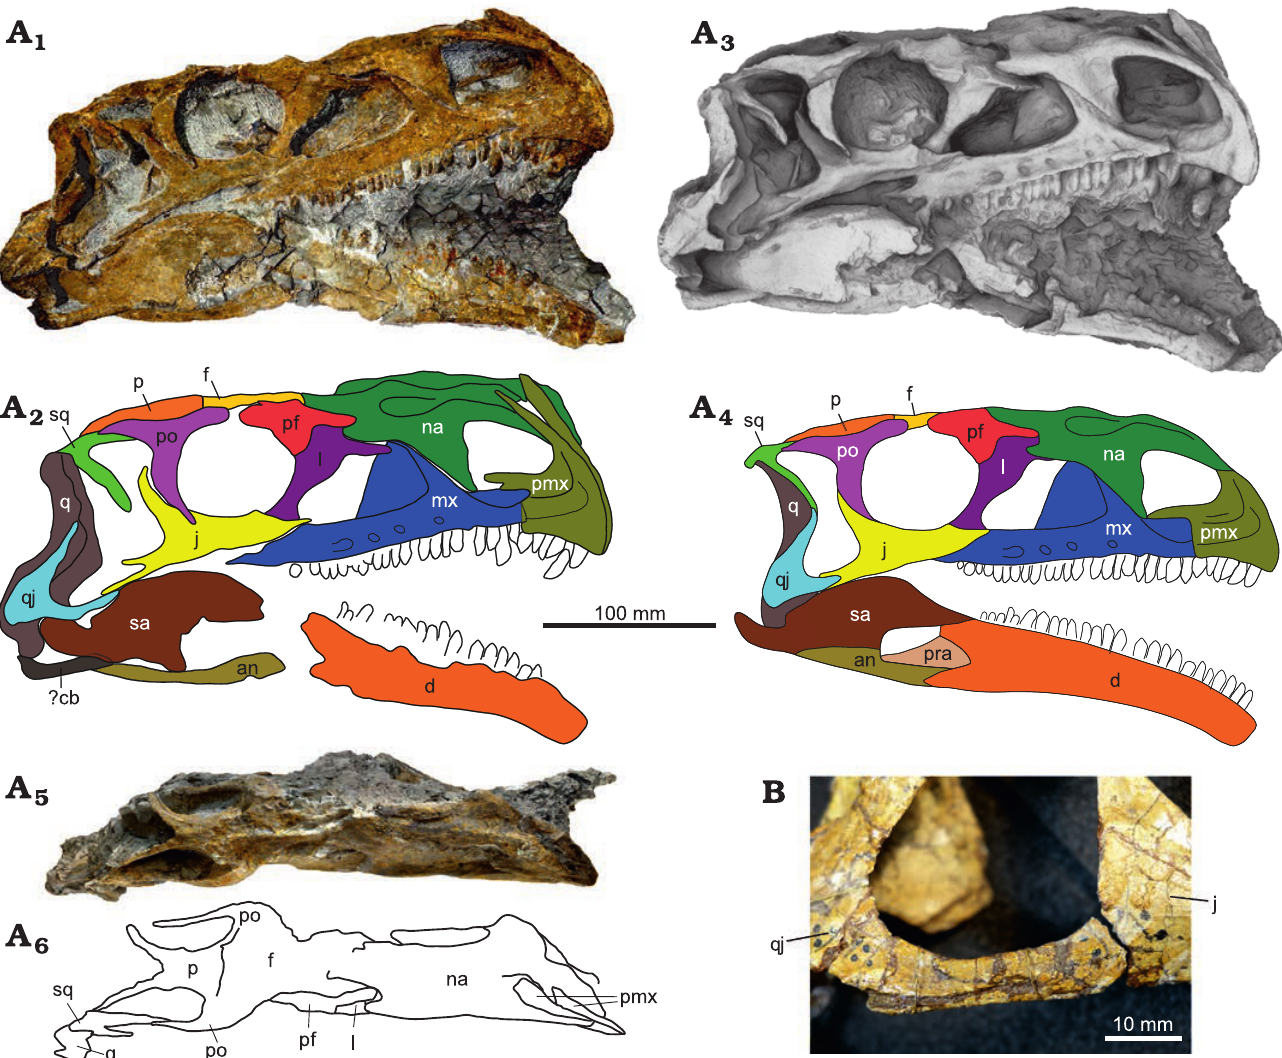
Fig. 4. A . Skull of Plateosaurus trossingensis ( MSF 11.4) from the Triassic of Frick, Switzerland. Photograph of the right side (A 1 ) and interpretative diagram (A 2 ); ambient occlusion of the 3D-model of the right side (A 3 ) and interpretative diagram (A 4 ); photograph in dorsal view (A 5 ) and interpreta - tive diagram (A 6 ). B . The jugal-quadratojugal articulation as seen in GPIT-PV-30784 from Trossingen. Abbreviations: an, angular; cb, ceratobranchial; d, dentary; f, frontal; j, jugal; l, lacrimal; mx, maxilla; na, nasal; p, parietal; pf, prefrontal; pmx, premaxilla; po, postorbital; pra, prearticular; q, quadrate; qj, quadratojugal; sa, surangular; sq,